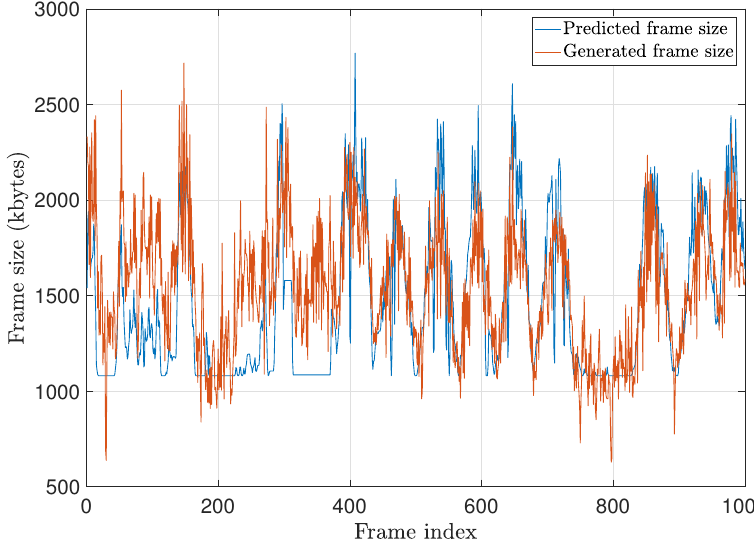
Figure 9. Predicted frame size vs. generated frame size.